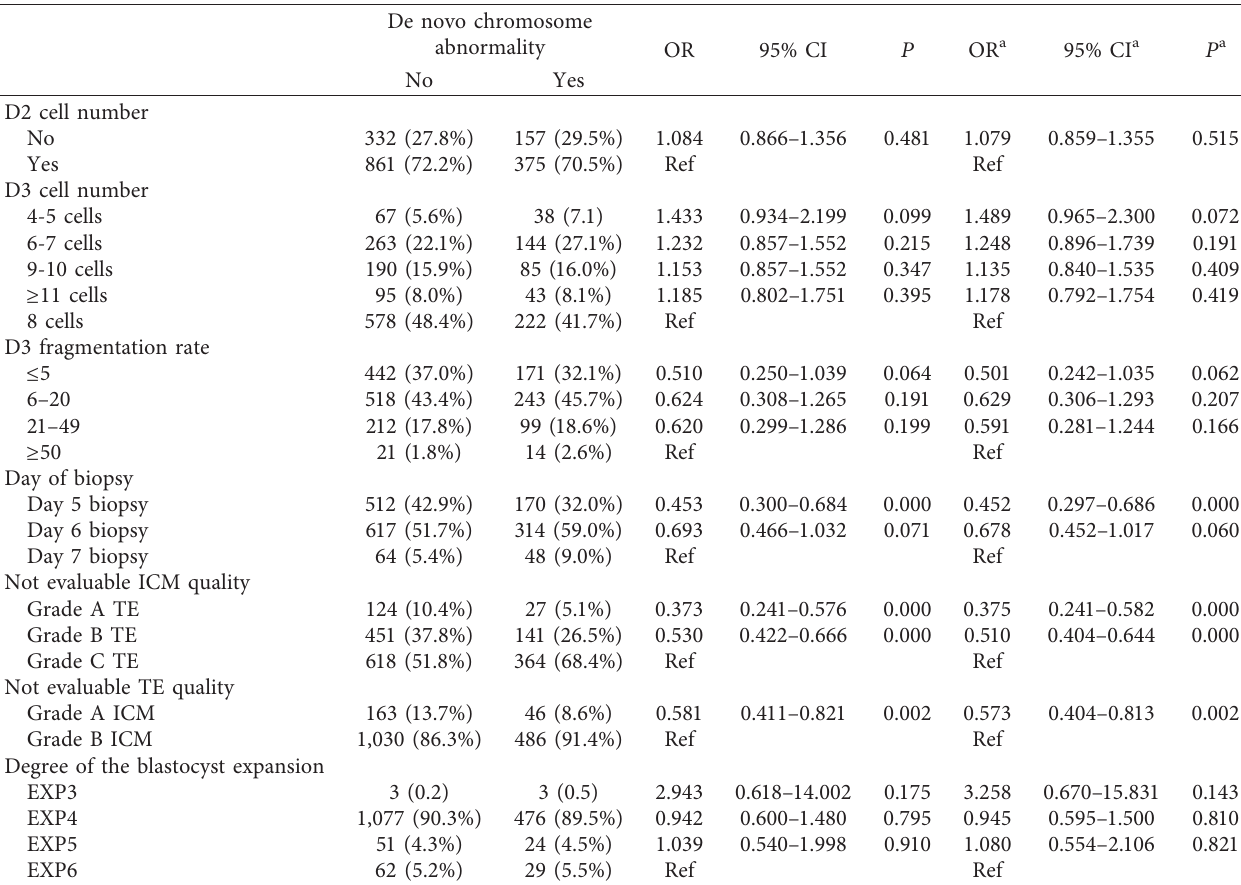
Table 4: Incidence of de novo chromosome abnormalities in relation to embryo quality in PGT